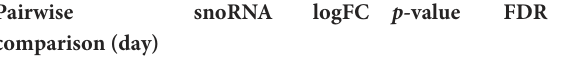
TABLE 3A Differentially expressed snoRNAs following pairwise analysis in plasma-derived